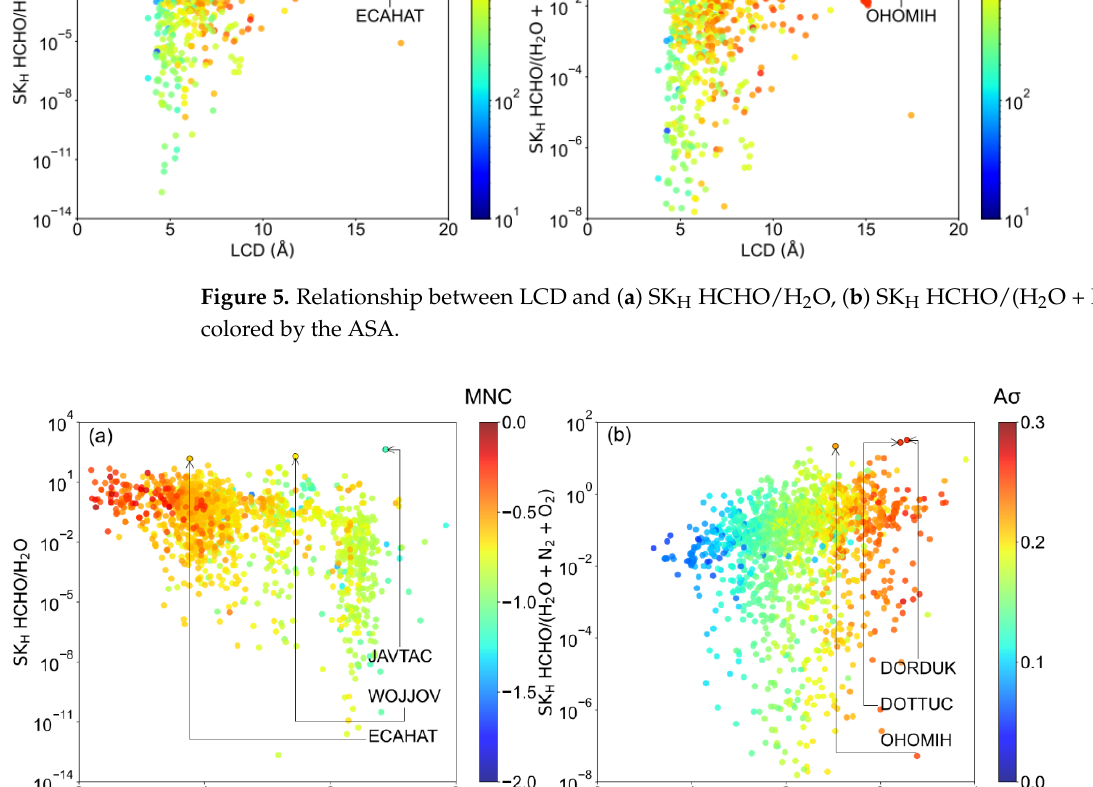
Figure 5. Relationship between LCD and ( a ) SK H HCHO/H 2 O, ( b ) SK H HCHO/(H 2 O + N 2 + O 2 ), col- ored by the ASA.